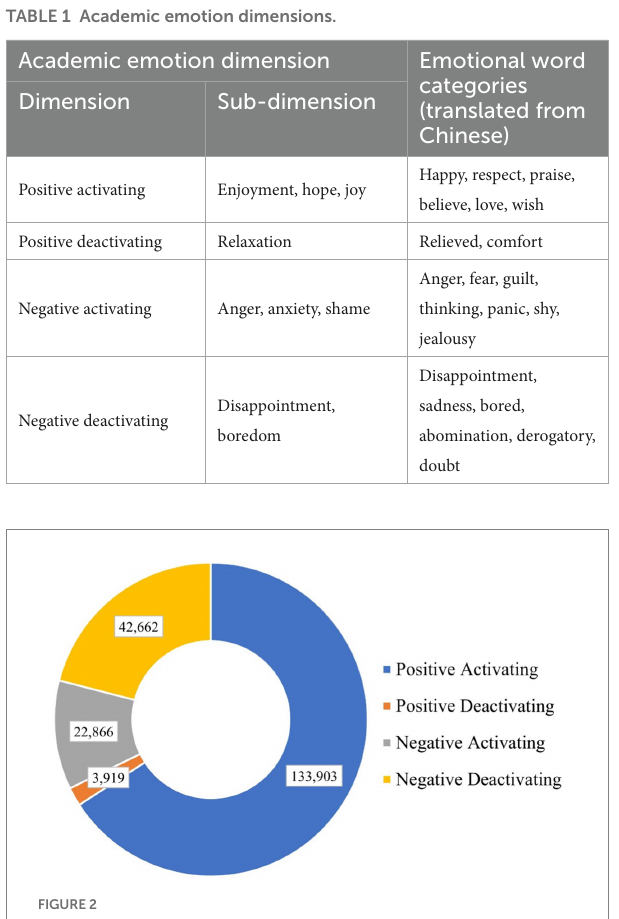
FIGURE 2 Academic emotion dimensions labeling